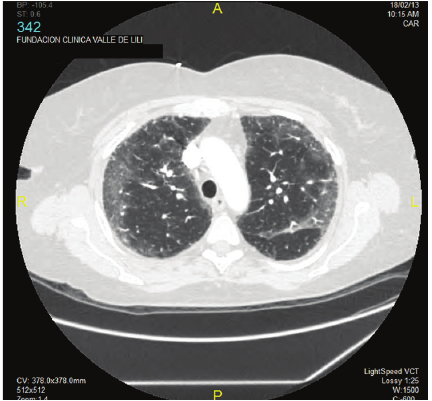
Figure 1: Chest computed tomography showing diffuse reticular interstitial infiltrates with ground-glass pattern of nonspecific inter- stitial pneumonia in a rheumatoid arthritis patient with Pneumocys- tis jirovecii